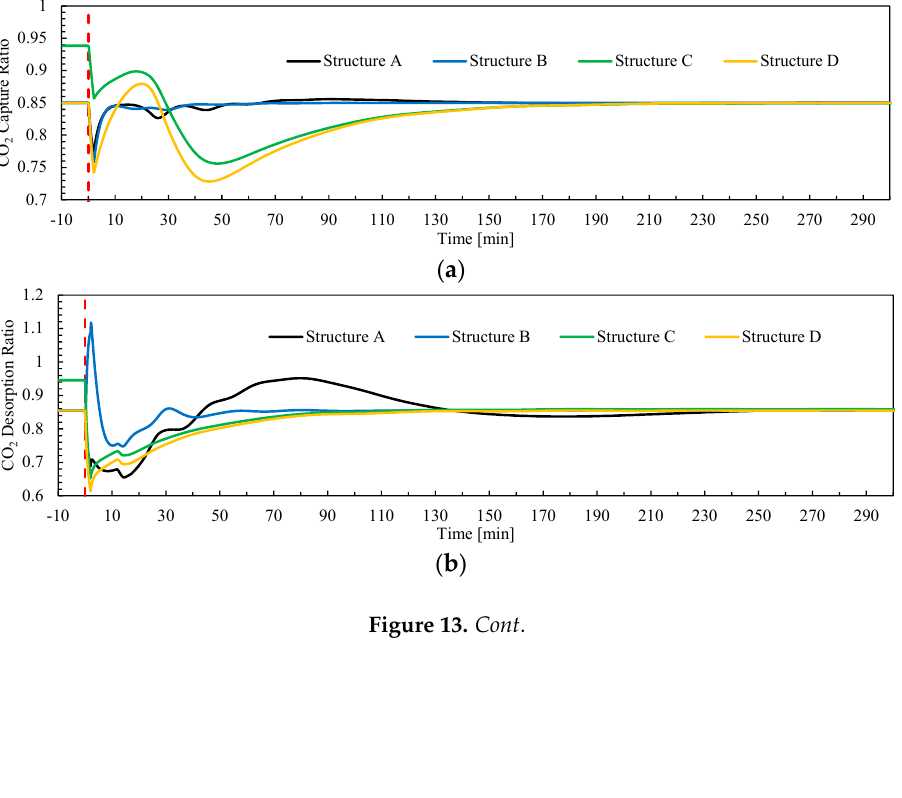
Figure 13. Outputs from pilot plant model during simulations for load change ramp-up (Test 2) from 70 to 100% with a ramp rate of 10%/min increase in flue gas flow rate, for control structures A, B, C and D. ( a ) CO 2 capture ratio Cap , as controlled variable (CV); ( b ) CO 2 desorption ratio Des ; ( c ) CO 2 absorption and desorption rates (kg/s). The red vertical dotted line shows when the transient event starts at t 0 .